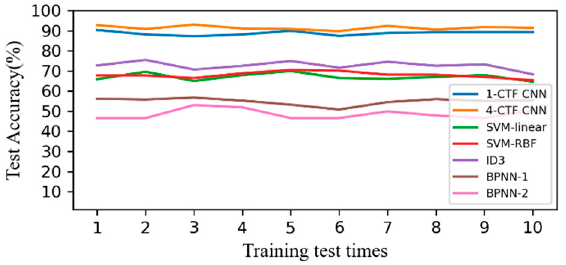
Figure 12. Defect recognition result of seven models.